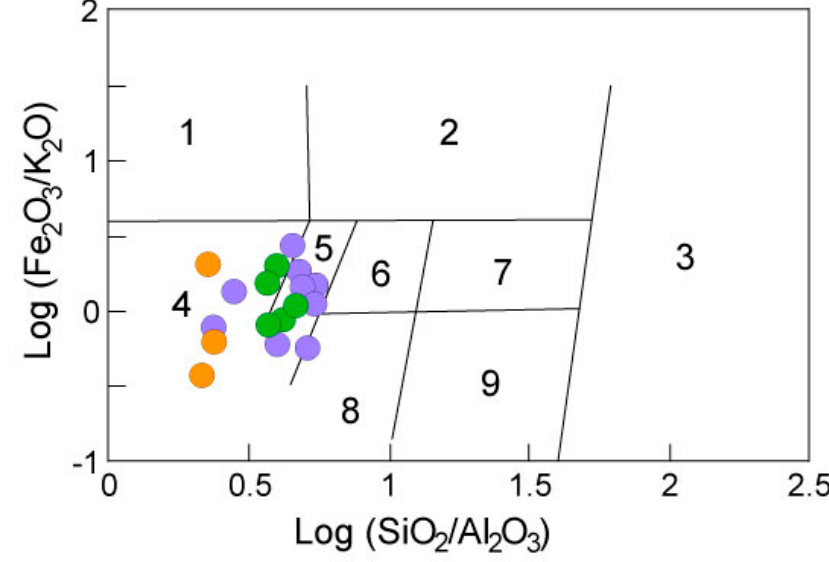
Figure 5. Geochemical classification of sedimentary rocks on the log (Fe 2 O 3 / K 2 O) versus log (SiO 2 / Al 2 O 3 ) diagram [25] showing protolith compositions of kornerupine-bearing biotite gneiss from Ringwood (green circles), Mase Mountain (orange circles), and biotite gneiss without kornerupine from elsewhere in the New Jersey Highlands (blue circles) Fields: 1, Fe-shale; 2, Fe-sandstone; 3, quartz arenite; 4, shale; 5, wacke; 6, litharenite; 7, sublitharenite; 8, arkose; 9, subarkose. Data from [7,15,19].